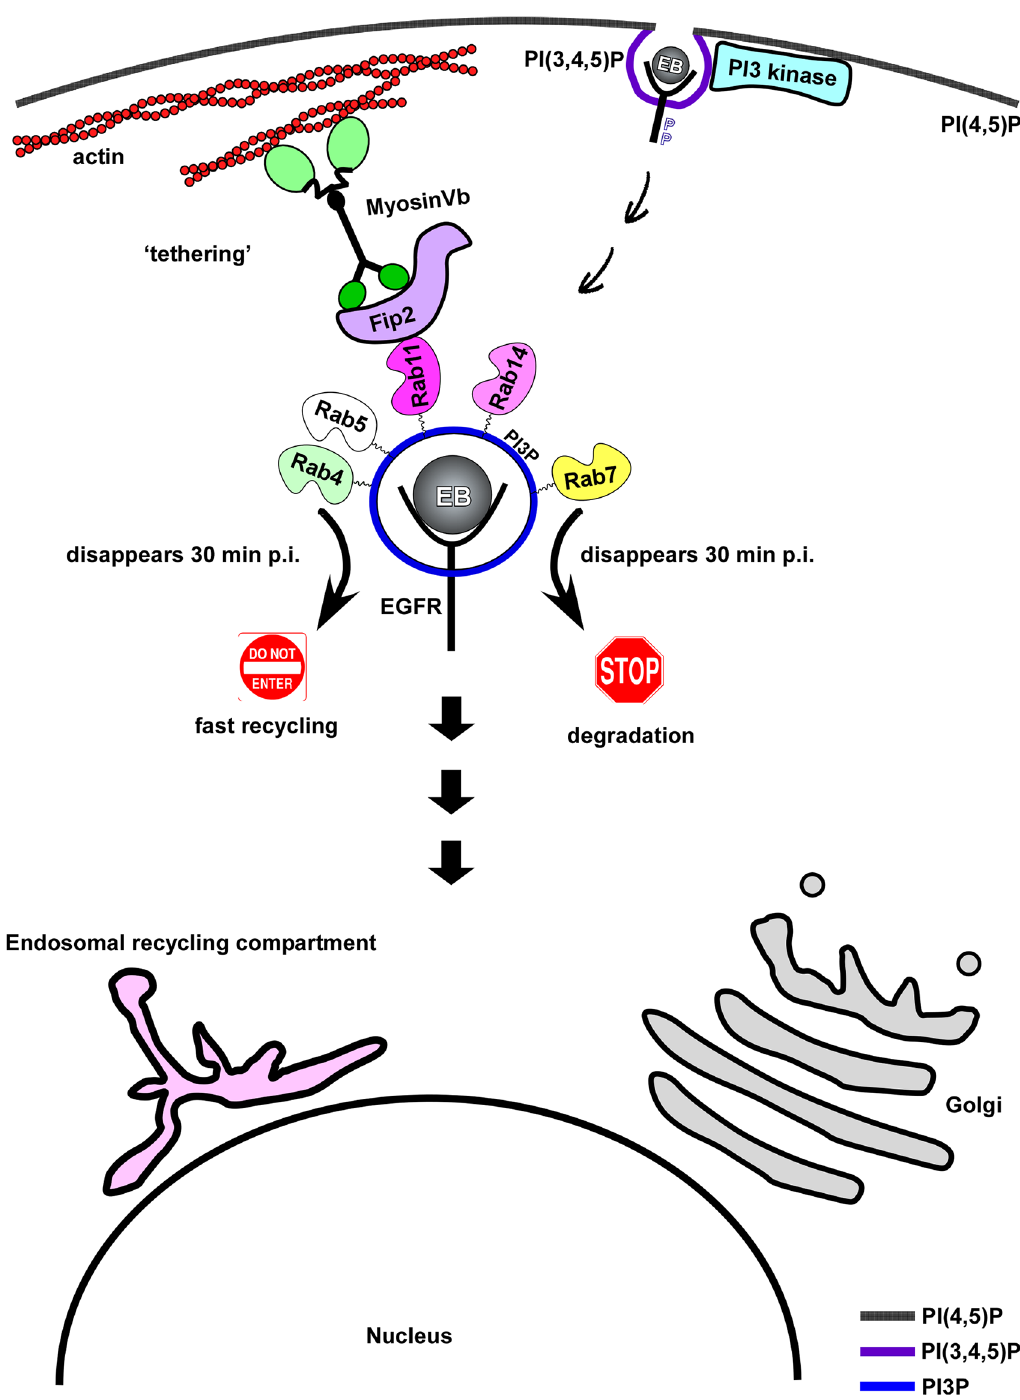
Fig 7. Model of early internalization and establishment of intracellular niche. The model shows that bindingand internalizationof C . pneumoniae EBs is mediatedby EGFR and requiresreceptor activation.Activated EGFR stimulates the PI3 kinase locatedat the plasma membrane, thus generatingPI(3,4,5)P, which is convertedto PI3P. The internalizedEB remainsin a PI3P-positive endosome,which acquires severalRab GTPases e.g. Rab4, Rab5, Rab7, Rab11 and Rab14. Loss of Rab4 and Rab7 subsequently mark the early inclusionas a recyclingendosome.In additionthe Rab11/Rab14 adaptor protein Rab11-Fip2 is recruited, which is essential for intracellular positioningof the inclusion.This is achievedby interactionof Fip2 with the actin-based motor protein myosin Vb.